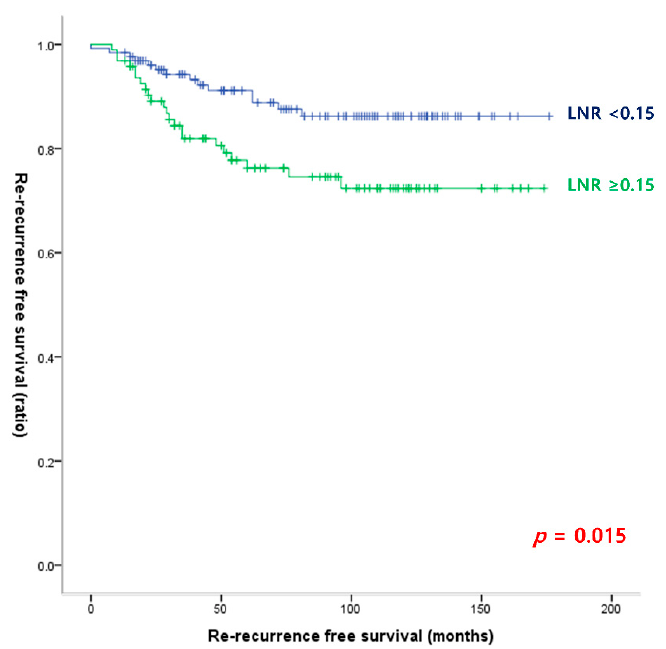
Figure 4. Re-recurrence-free survival curves according to the lymph node ratio cutoff of 0.15 (log-rank Figure 4. Re ‐ recurrence ‐ free survival curves according to the lymph node ratio cutoff of 0.15 (log ‐ p = rank p = 0.015).